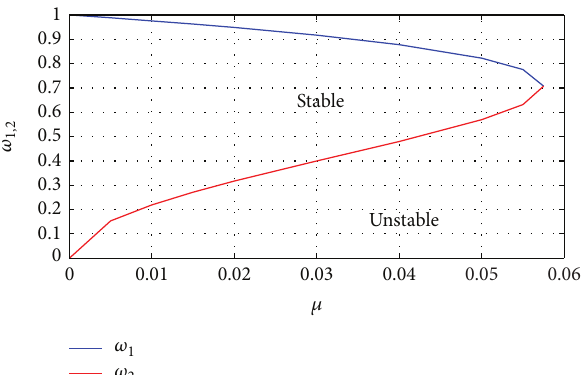
Figure 12: Correlation between 𝜇 and 𝜔 1,2 .